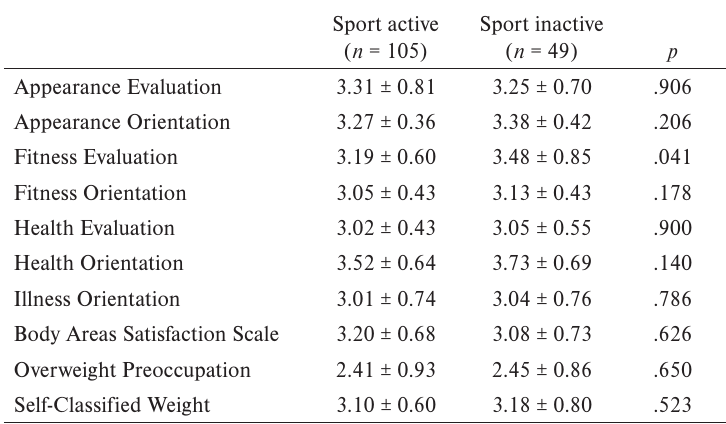
Mean ± SD and statistical significance of differences between sport